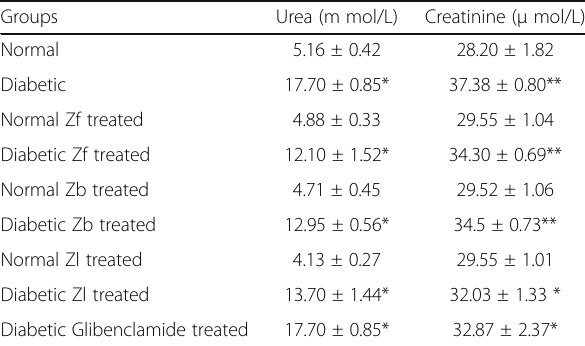
Table 5 The effect of extracts of Zanthoxylum armatum and standard drug Glibenclamide on serum urea and creatinine level in normal and diabetic mice